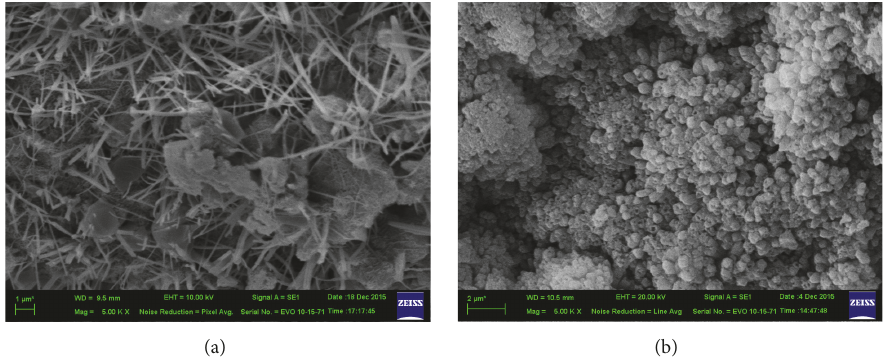
Figure 16: SEM of mortar with 15% EX + 2% SRA: (a) cured at 30 ∘ C; (b) steam-cured at 65 ∘ C.